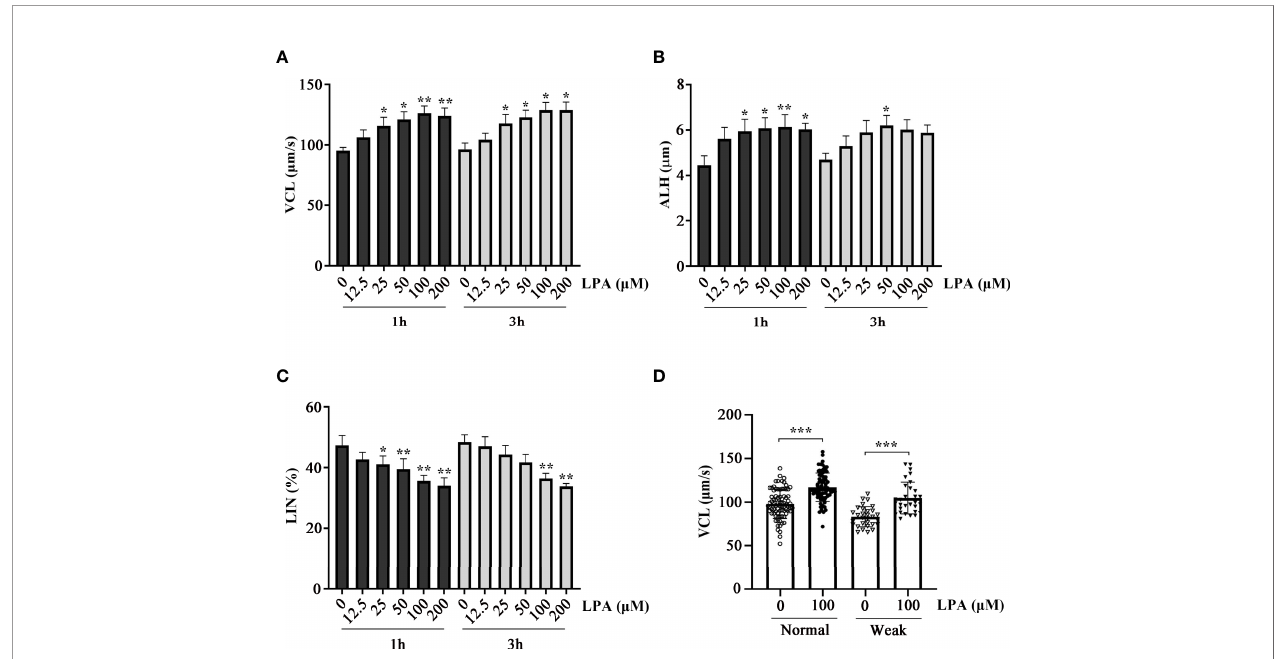
FIGURE 1 | Effect of lysophosphatidic acid (LPA) on human sperm motility. (A – C) Dose-dependent effects of LPA on sperm motility. Normal human spermatozoa were treated with LPA (0, 12.5, 25, 50, 100, and 200 µM) for 1 h and 3 h in the Biggers, Whitten, and Whittingham (BWW) medium. Parameters of sperm motility, VCL (A) , ALH (B) , and LIN (C) , were examined using computer-assisted sperm analysis. Results are expressed as mean ± SEM ( n = 6). * p < 0.05, ** p < 0.01 as compared with the corresponding control (0 µM); VCL: curvilinear velocity; ALH: amplitude of lateral head displacement; LIN: linearity. (D) Effect of LPA (100 µM) on the VCL of spermatozoa from healthy individuals ( n = 80) and patients with asthenozoospermia ( n = 30). The motility was assessed after spermatozoa were treated with LPA (0 and 100 µM) for 1 h in the BWW medium. Results are expressed as mean ± SEM. *** p < 0.001 as compared with the corresponding control (0